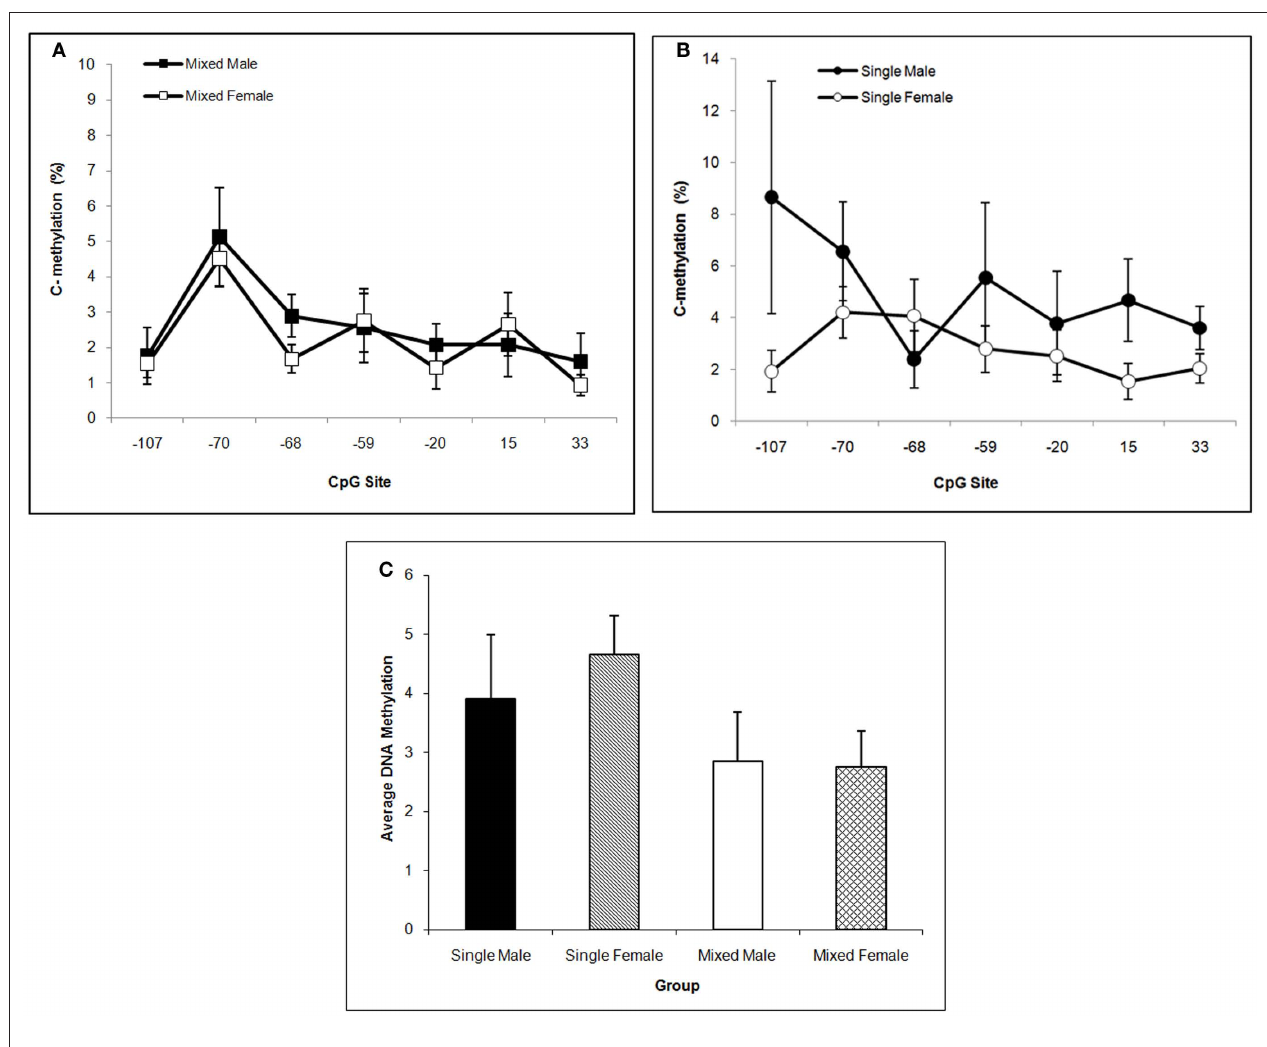
FiguRE 7 | Mean ( ± SEM) DNA methylation levels of the Oprm1 gene promoter region in caudate–putamen are presented for mixed- [squares; (A)] and single- [circles; (B)] sex litters for male (closed symbols) and